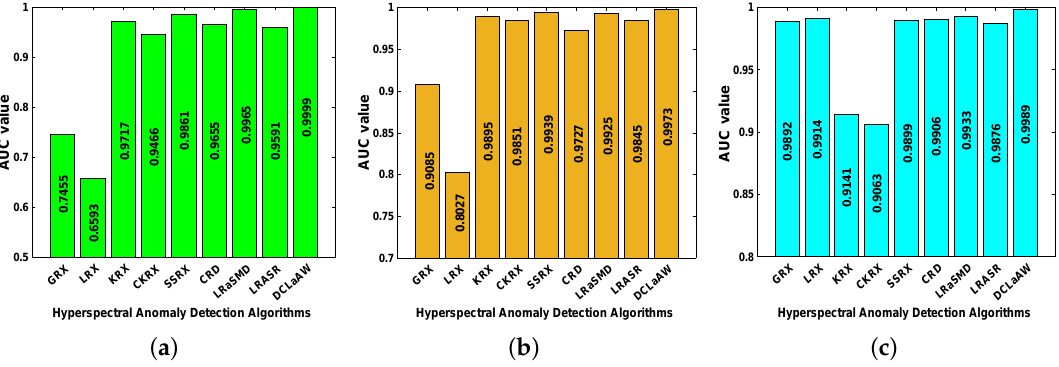
Figure 19. AUC values of all compared algorithms for each dataset. ( a ) Synthetic dataset; ( b ) San Diego dataset; ( c ) Urban